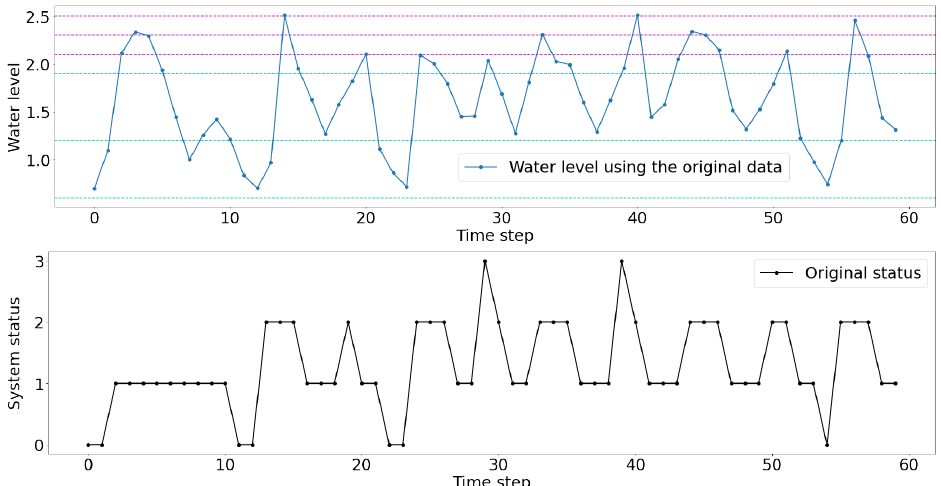
Figure 1. The water level and the number of active pumps for 60 consecutive entries of the